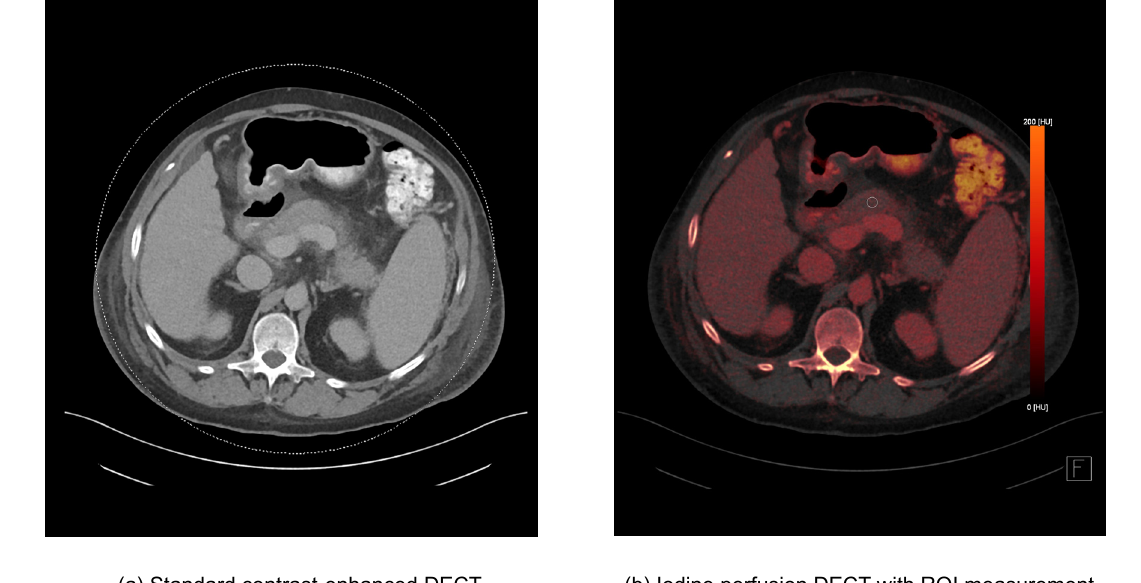
Figure 2. DECT iodine quantification segmentation. Axial DECT images of a 56-year-old male patient with moderate acute pancreatitis (CTSI = 6). ( a ) Standard contrast-enhanced DECT, ( b ) iodine perfusion DECT with ROI measurement for DECT material decomposition analysis.